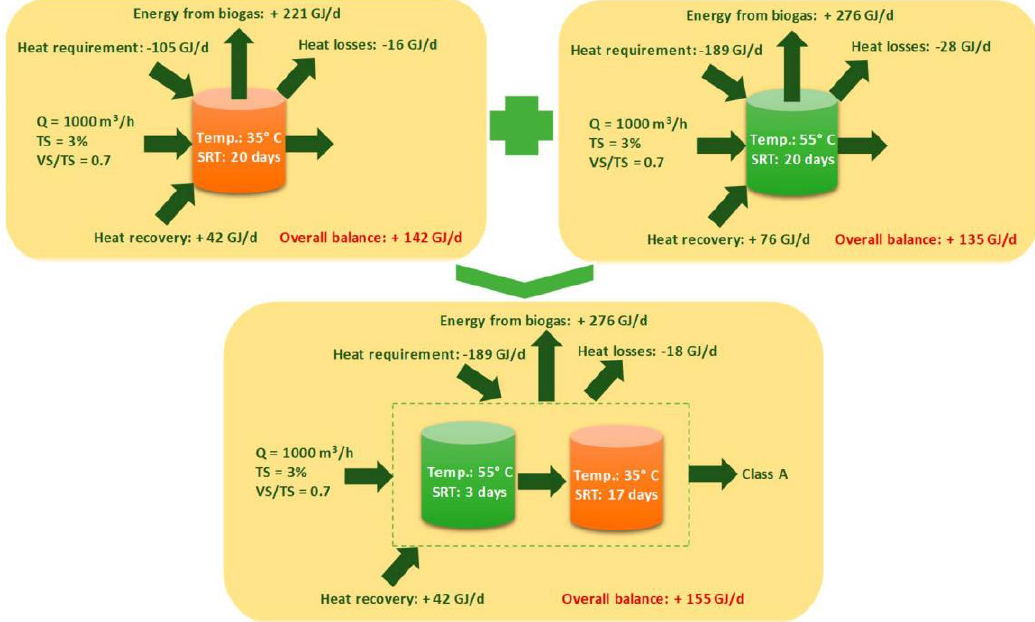
Figure 6. Higher energy generation from a two-stage thermophilic-mesophilic digestion compared